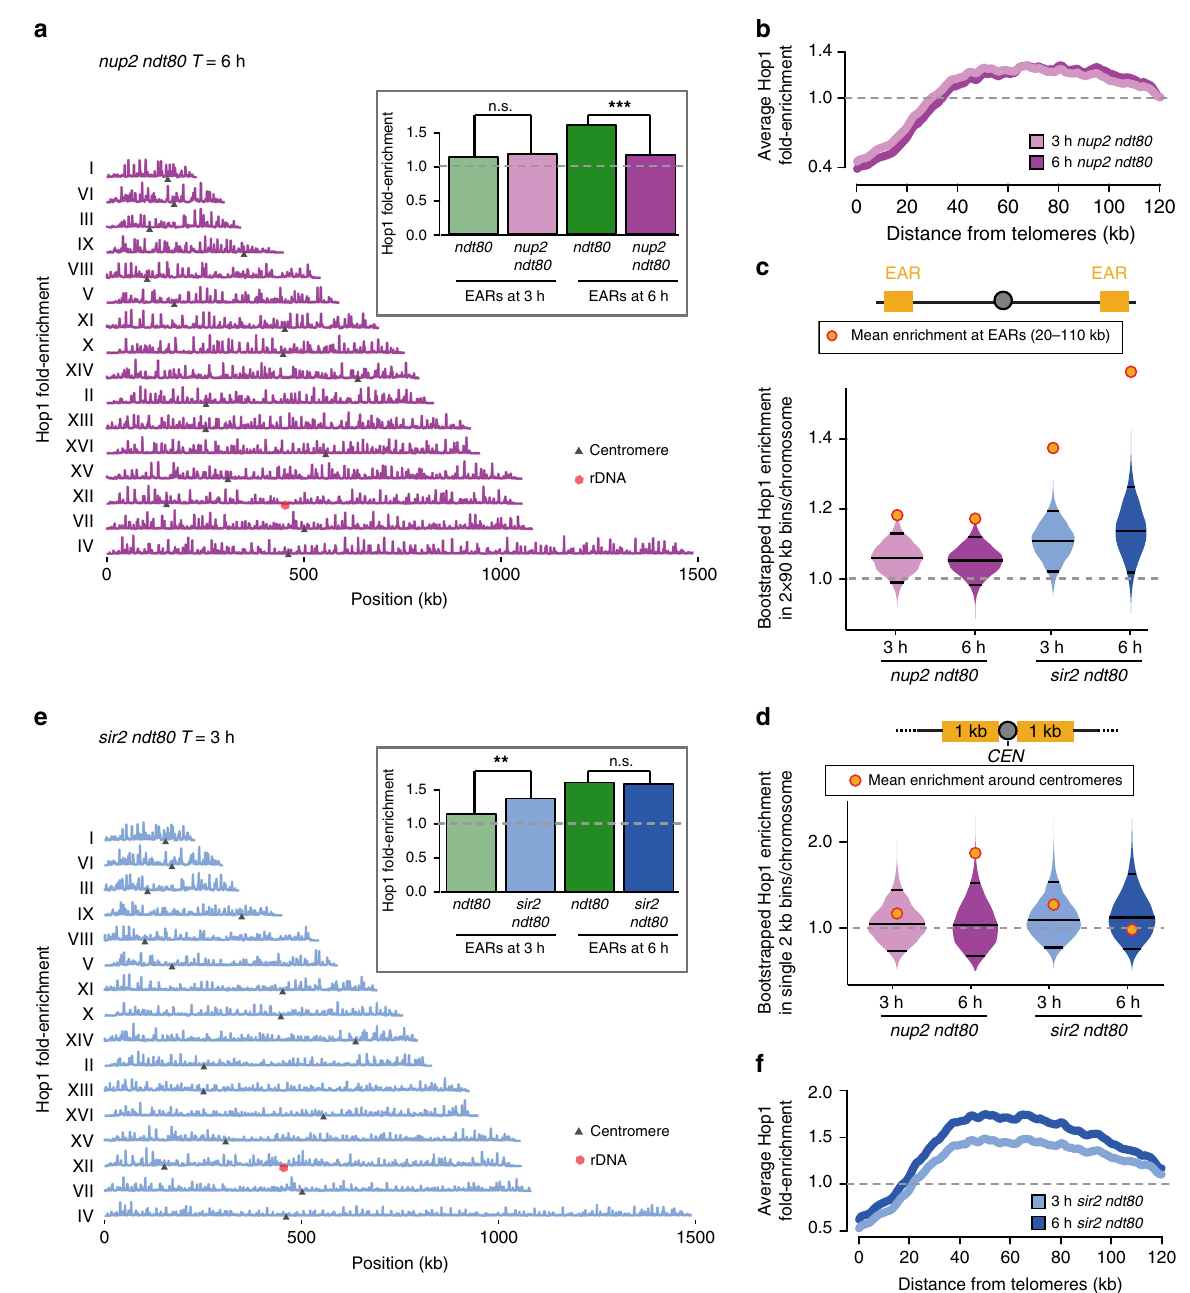
Fig. 6 Nup2 and Sir2 also regulate regional Hop1 distribution in prophase. a Hop1 ChIP-seq enrichment in late prophase cells ( T = 6 h) from nup2 Δ ndt80 Δ in magenta is plotted along each of the 16 yeast chromosomes; black triangles mark the centromeres and the red hexagon marks the rDNA locus. The data are normalized to a global mean of 1. Inset shows mean Hop1 enrichment in EARs (20 – 110 kb) in nup2 Δ ndt80 Δ during early prophase ( T = 3 h, pink) and late prophase ( T = 6 h, magenta) compared to ndt80 Δ samples. *** P < 0.001, and n.s. not signi fi cant, Mann-Whitney-Wilcoxon test. b Mean Hop1 enrichment in the EARs (32 domains) is plotted as a function of the distance from telomeres in nup2 Δ ndt80 Δ . c Bootstrap-derived distributions within two 90-kb bins per chromosome from Hop1 ChIP-seq data illustrated as violin plots for nup2 Δ ndt80 Δ (pink), and sir2 Δ ndt80 Δ (blue). The horizontal lines in the violin plots represent the median and the two-ended 95% CIs. The mean Hop1 ChIP-seq enrichment in EARs (20 – 110 kb) for the respective samples is shown as orange/red dots. The gray dashed line is genome average. d Bootstrap-derived distributions within single 2-kb bins per chromosome are illustrated as violin plots for Hop1 ChIP-seq data from nup2 Δ ndt80 Δ (pink), and sir2 Δ ndt80 Δ mutants (blue) are illustrated as violin plots. The horizontal lines in the violin plots represent the median and the two-ended 95% CIs. The mean Hop1 ChIP-seq enrichment around centromeres (2 kb) for the respective samples is shown as orange/red dots. e Hop1 ChIP-seq enrichment in early prophase cells ( T = 3 h) from sir2 Δ ndt80 Δ in light blue is plotted along each of the 16 yeast chromosomes; black triangles mark the centromeres and the red hexagon marks the rDNA locus. The data are normalized to a global mean of 1. Inset shows mean Hop1 enrichment in EARs (20 – 110 kb) in sir2 Δ ndt80 Δ during early prophase ( T = 3 h, light blue) and late prophase ( T = 6 h, dark blue) compared to ndt80 Δ samples. ** P < 0.01, and n.s. not signi fi cant, Mann-Whitney-Wilcoxon test. f Mean Hop1 enrichment in the EARs (32 domains) is plotted as a function of the distance from telomeres in sir2 Δ ndt80 Δ